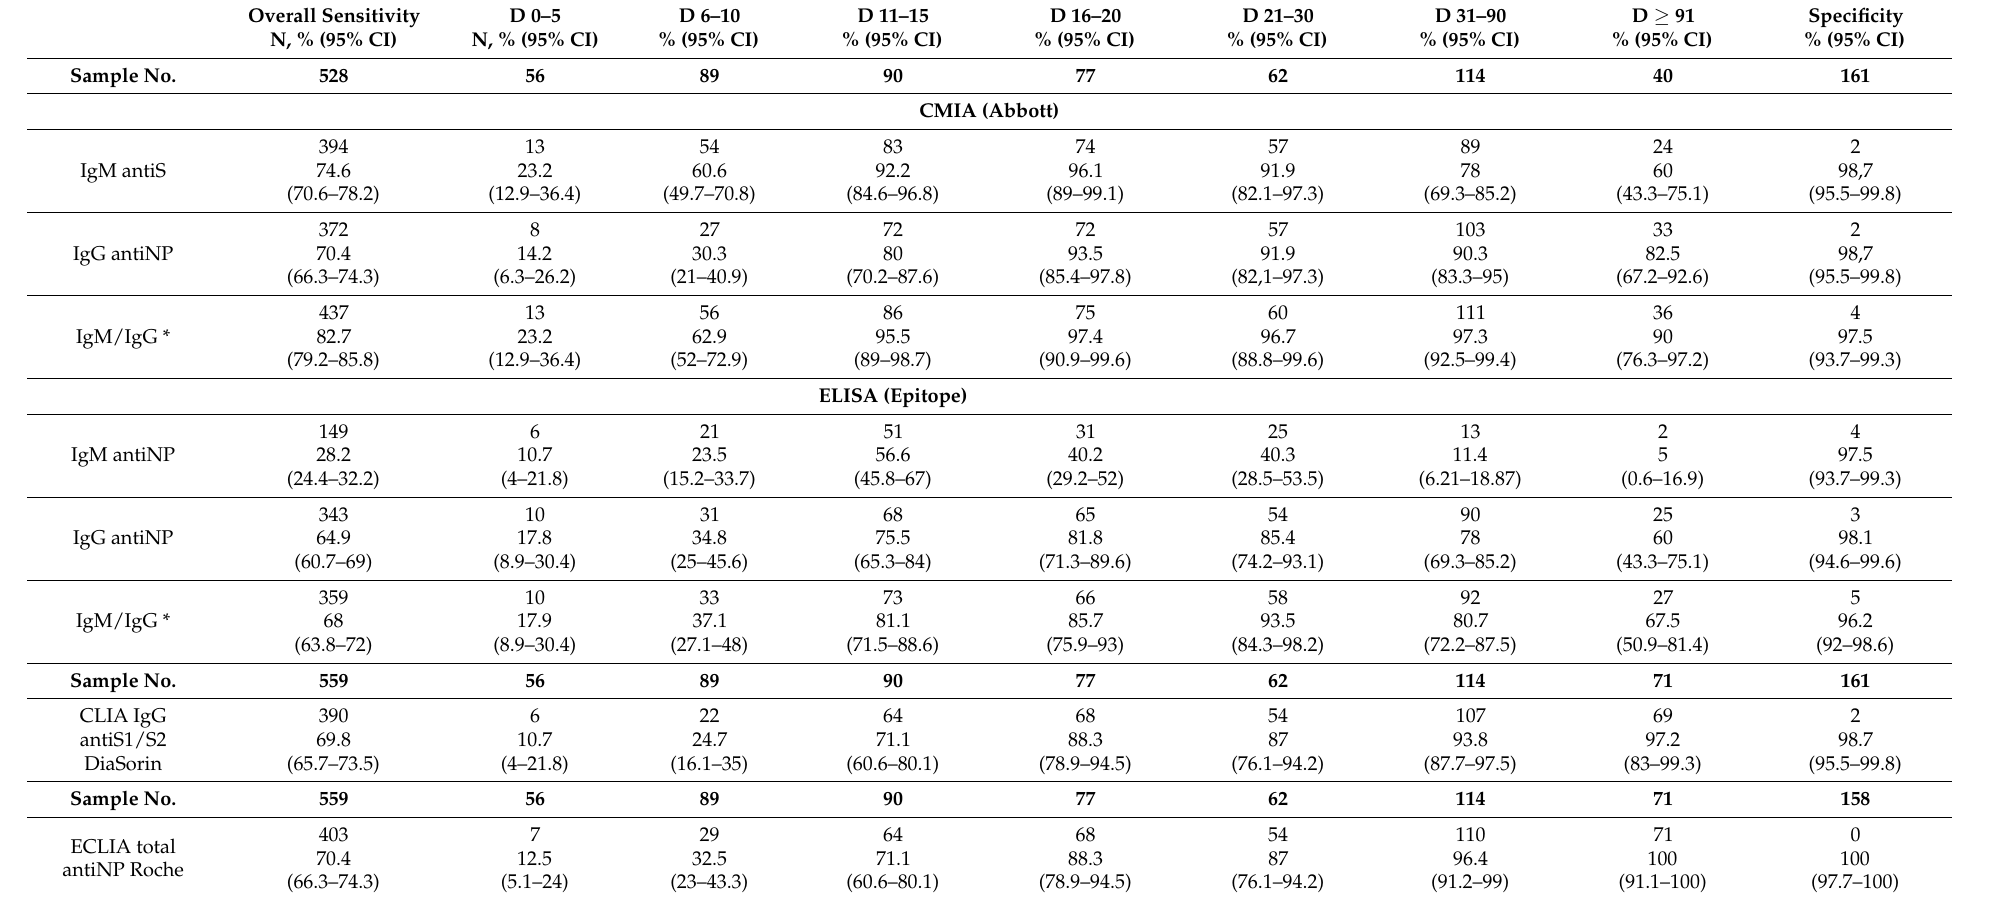
Table 2. Clinical sensitivity according to the time post symptom